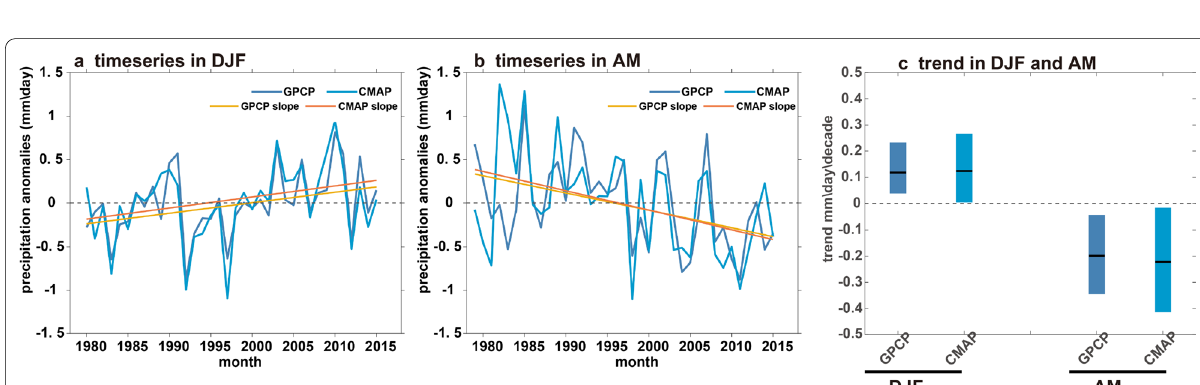
Fig. 3 The statistics of spatial averaged precipitation in observations. a , b Time series of observed precipitation anomalies over the African rainforest (dark box in Fig. 2) show an intensified tendency during the boreal winter dry season and a weaken tendency during the boreal spring wet season. c The black lines and thick bars represent precipitation change and 95% confidence